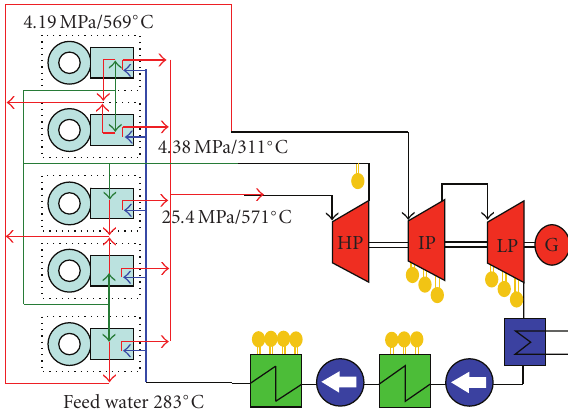
Figure 4: Matching pattern 2 of MHTGR-250 SC